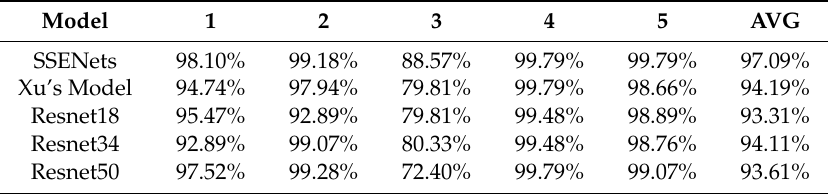
Table 9. The 5-fold cross-validation of